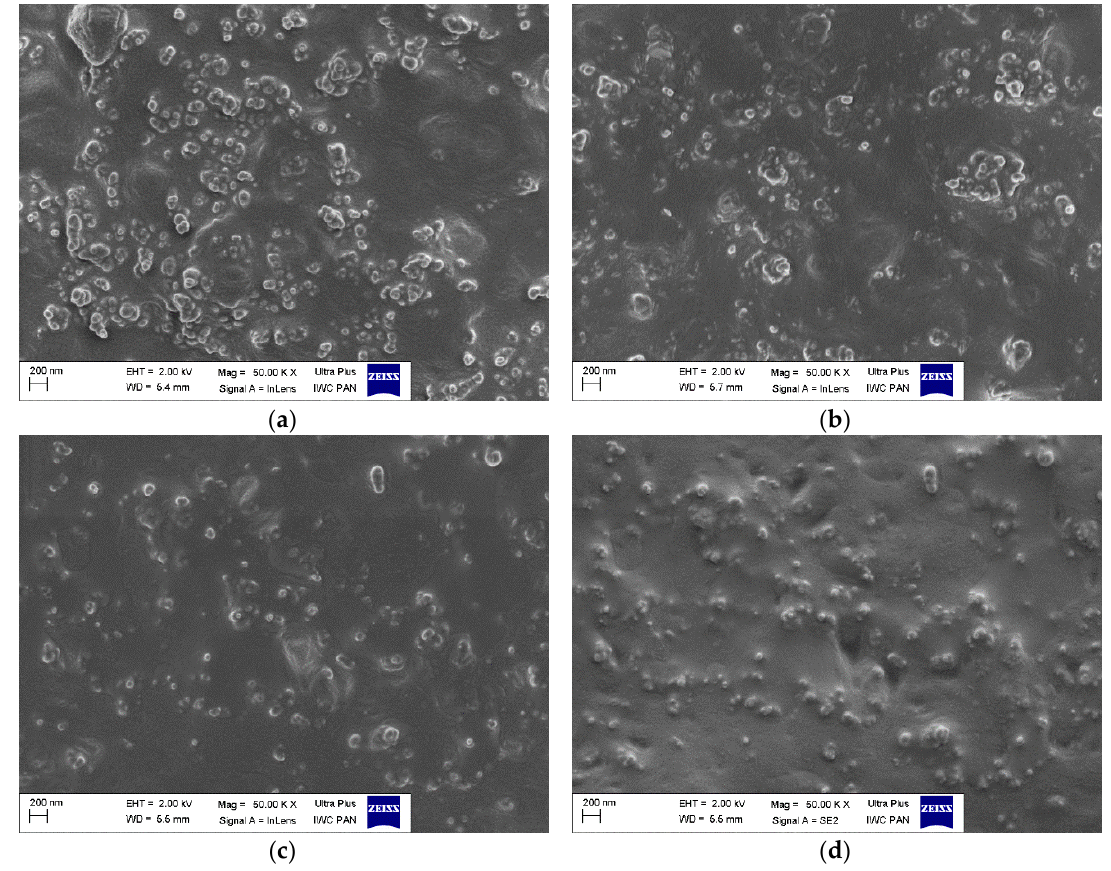
Figure 7. Scanning electron microscopy (SEM) images of SBR vulcanizates with 5 phr of varying activators: ( a ) ZnO, ( b ) AAcZn, ( c ) GluZn, ( d ) RicZn.